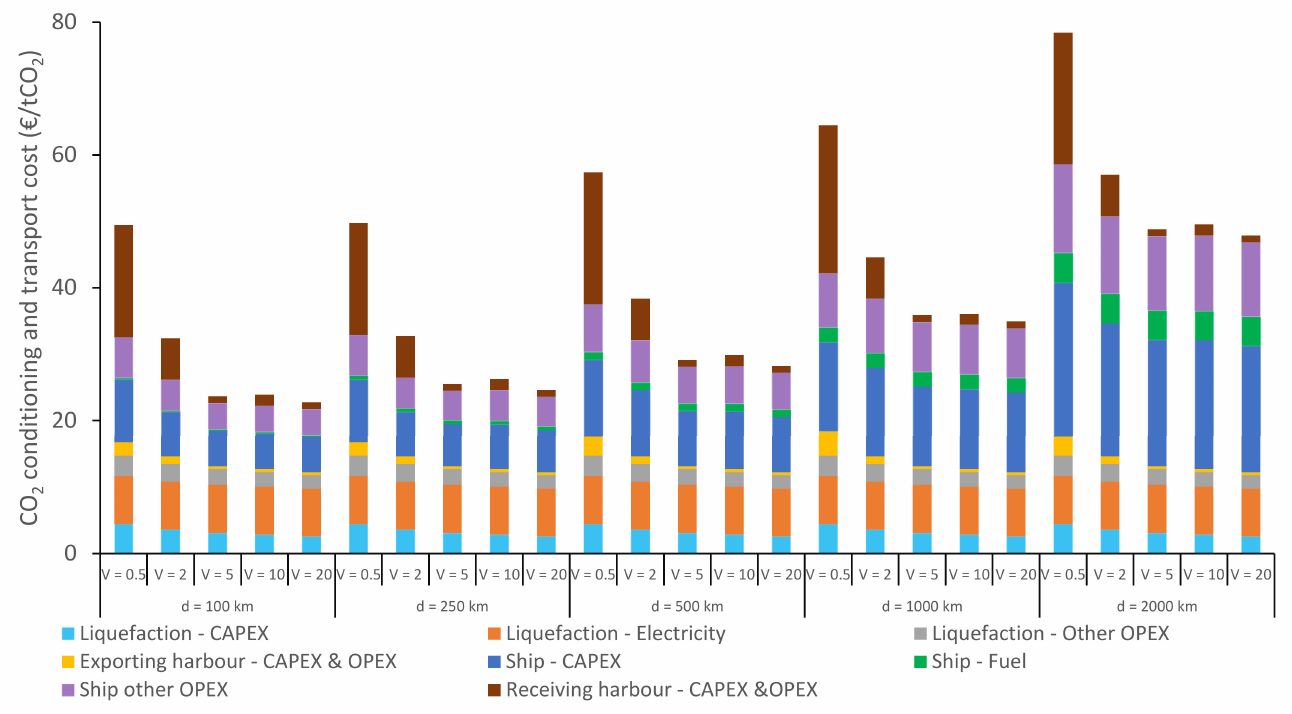
Figure A11. Cost breakdown of CO 2 conditioning and transport costs as a function of transport distance (d in km) and annual volume (V in MtCO 2 /year) when transporting pure CO 2 to an offshore site by ship at 15